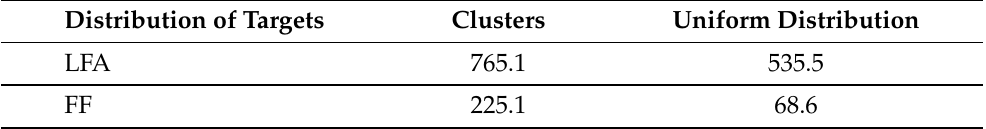
Table 5. Targets found when changing the targets distribution (clustered, uniform)— Scenario 4